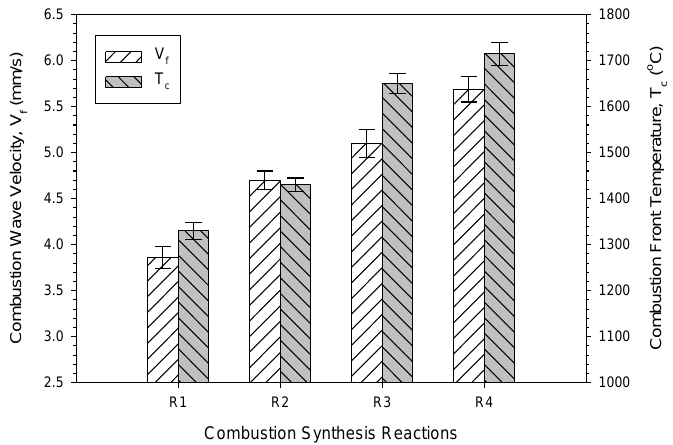
Figure 4. Combustion wave velocity ( V f ) and combustion front temperature ( T c ) measured from Equation (1),Equation (2), Equation (3), and Equation (4) for the synthesis of 3TiB 2 – MgAl 2 O 4 com-